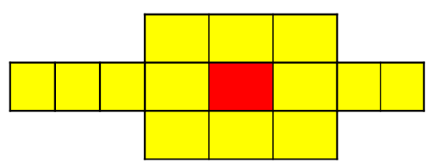
Figure 6. Aircraft model cellular neighborhood.